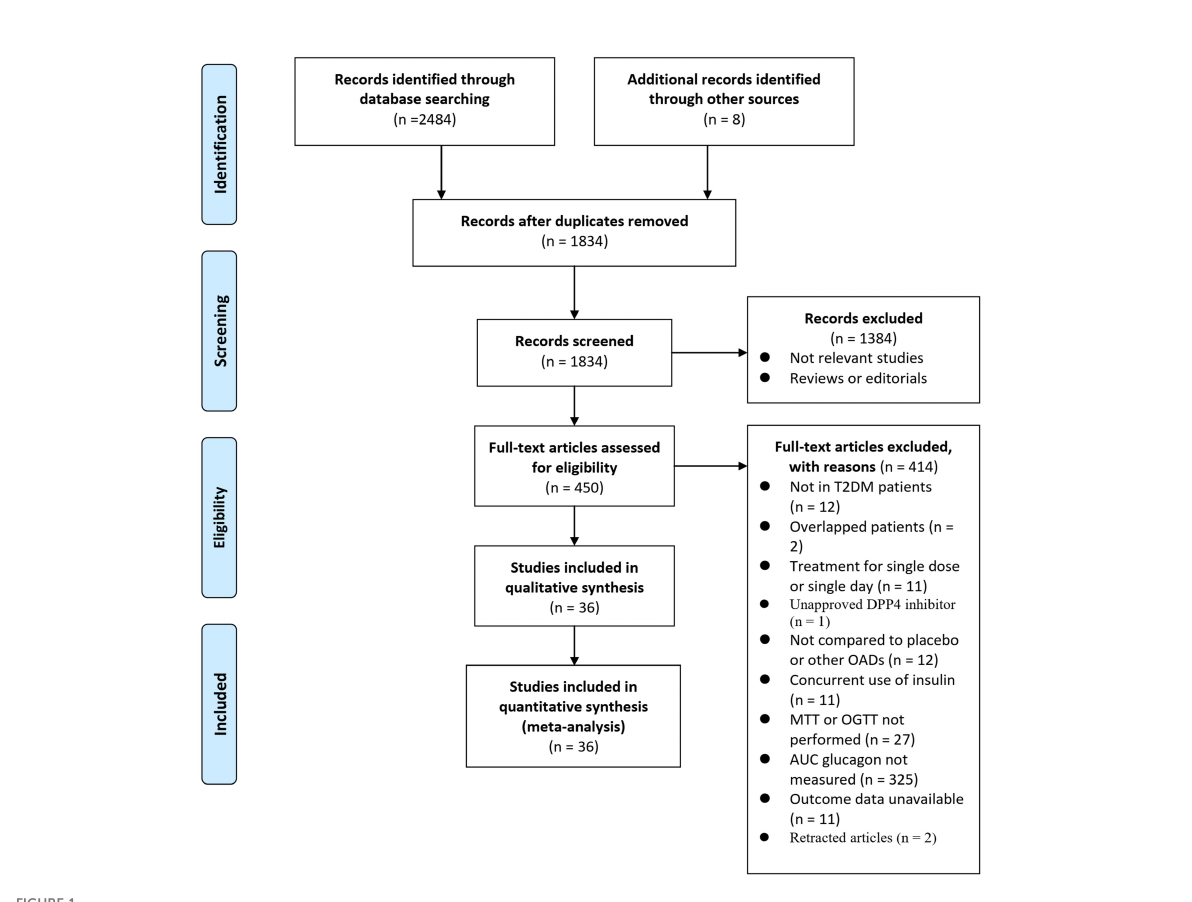
FIGURE 1 Flowchart of literature